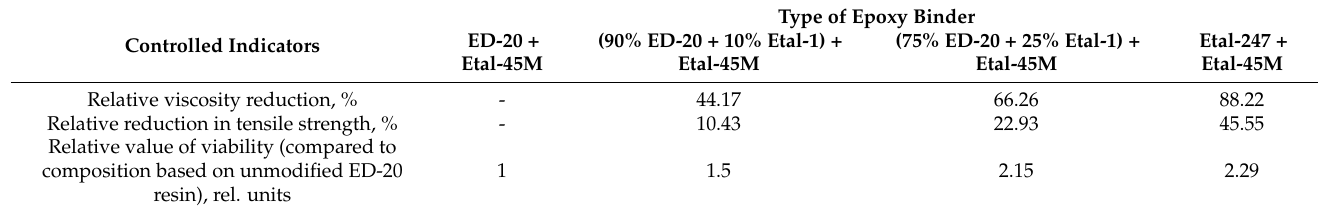
Table 4. The effectiveness of the modification of epoxy resins, taking into account the pot life